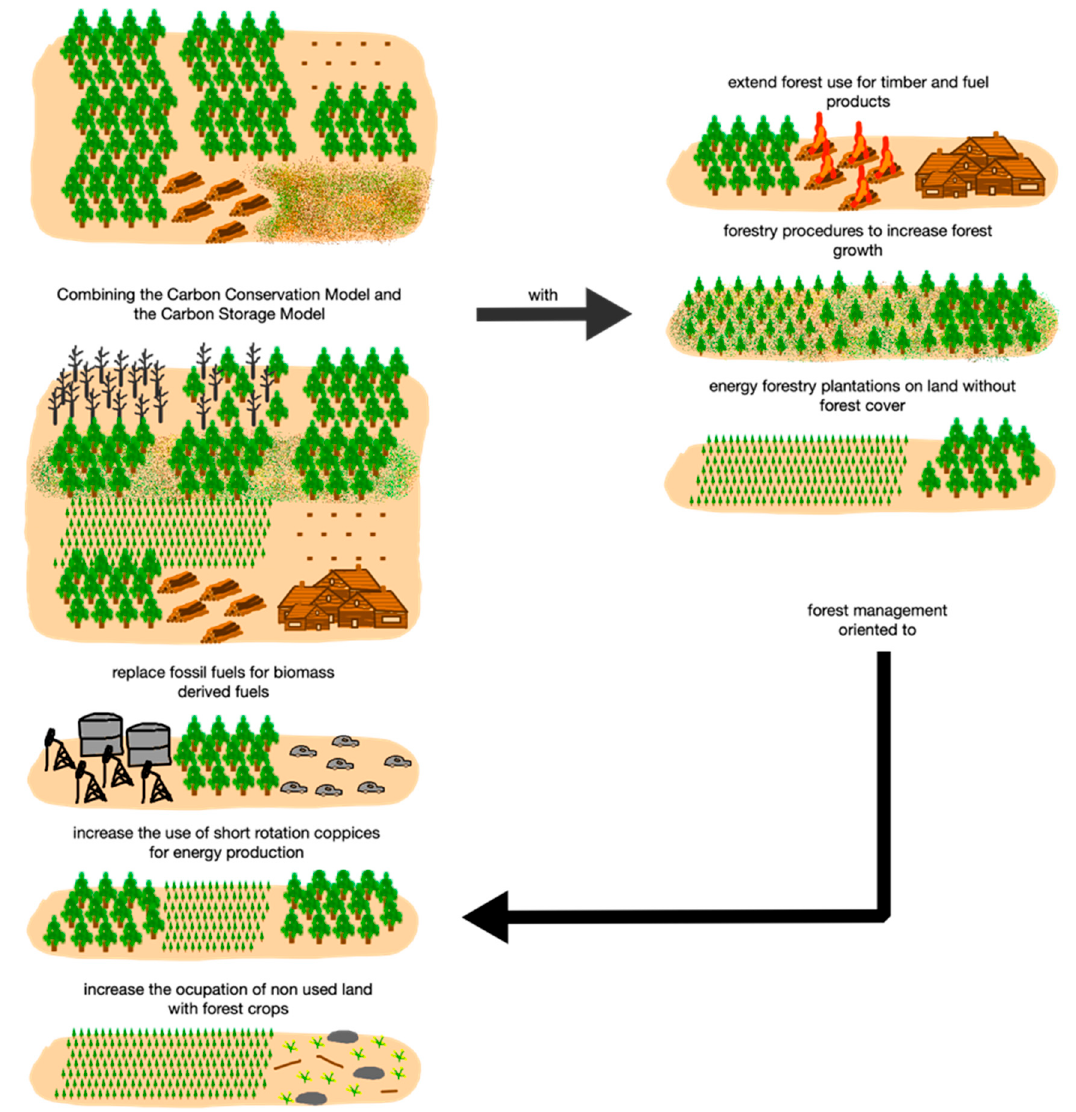
Figure 6. Forest management model for carbon substitution (adapted from [136] ).